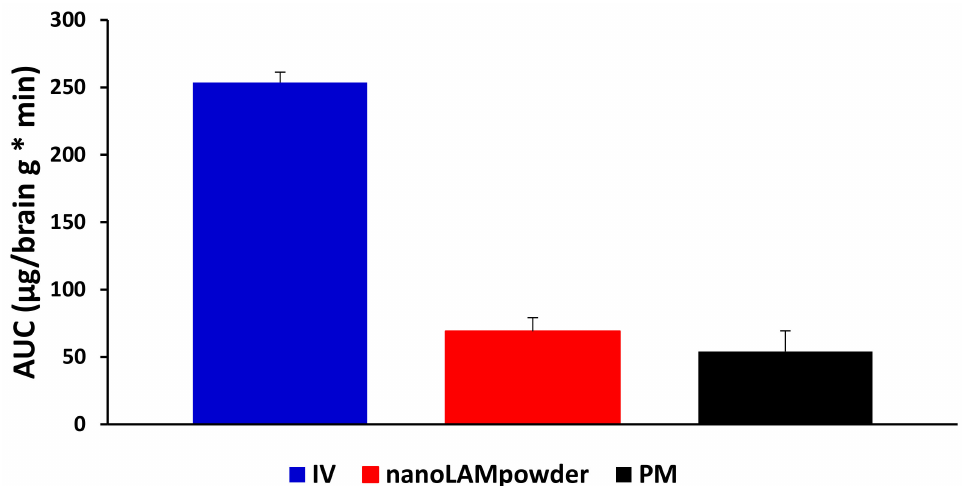
Figure 9. The cerebral AUC values of the formulations.